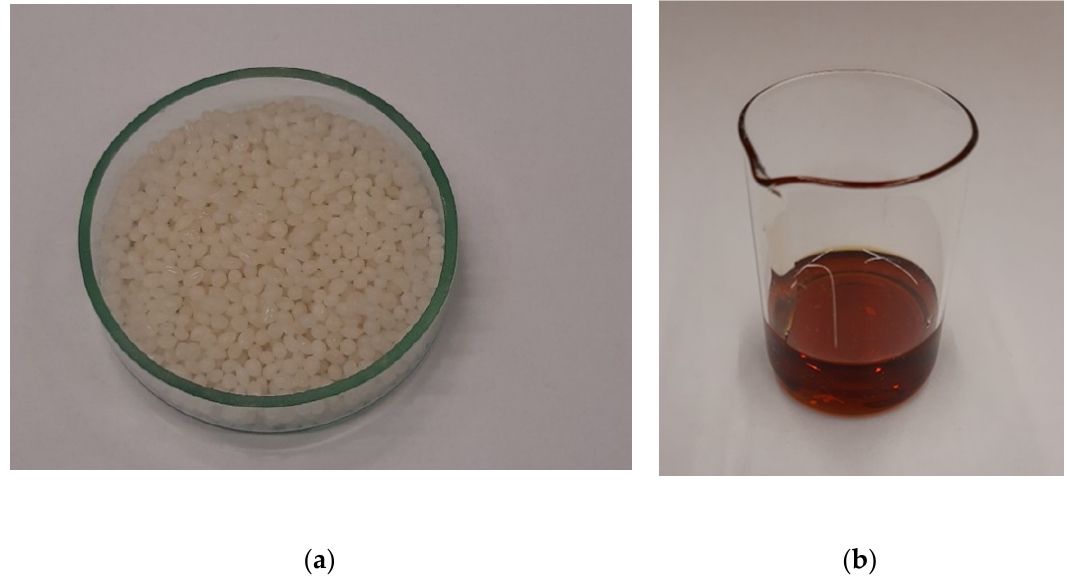
Figure 1. Chemical additives for foaming bitumen 50/70; Fischer–Tropsch (F–T) synthetic wax ( a ), surface-active agent ( b ) (photo by M. M. Iwa ń ski).